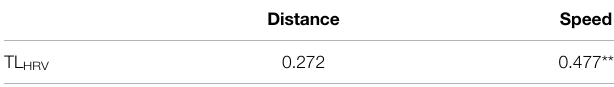
TABLE 5 | Correlations between TL HRV and external load measures.